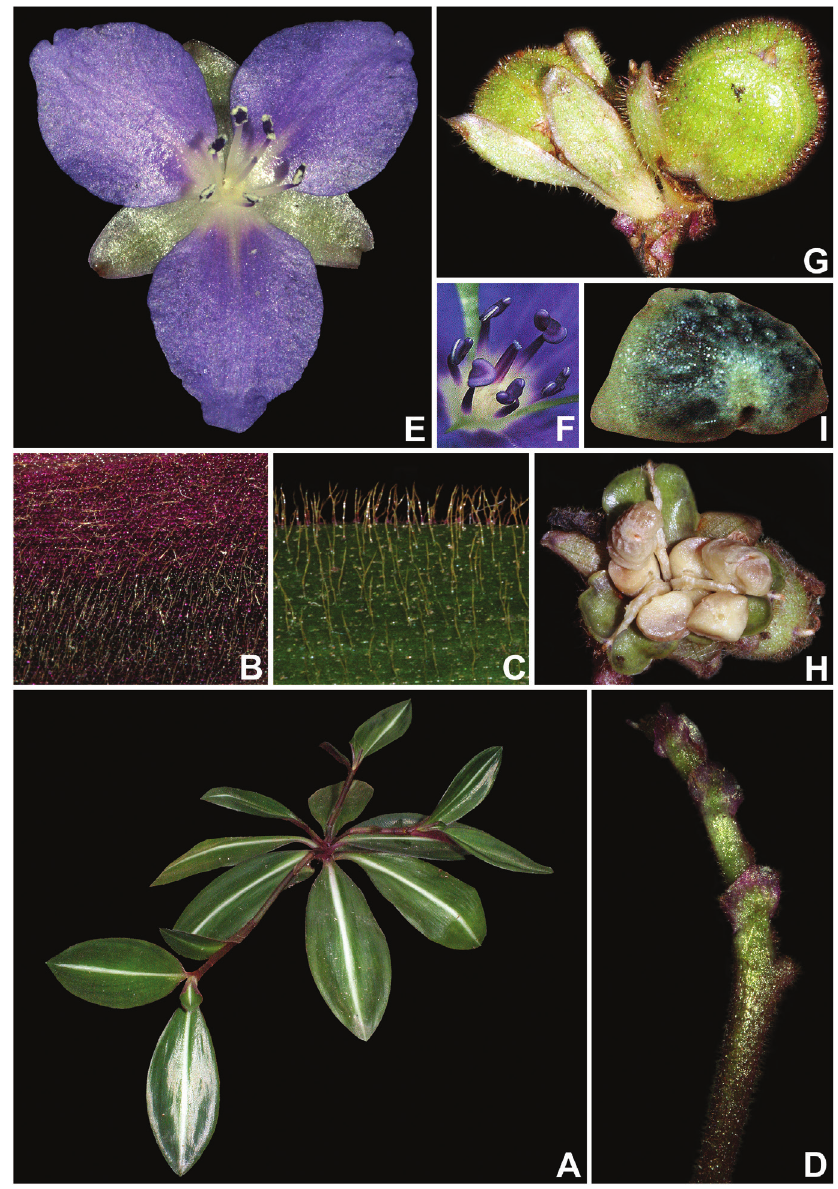
Figure 6. Siderasis albofasciata M.Pell. A habit, showing the well-defined white stripe along the midvein of the leaves and the flagelliform-shoots with terminal rosettes B detail of the abaxial side of the leaf, show- ing the light-brown lanate indumentum C detail of the adaxial side of the leaf, showing the light-brown hispid indumentum D detail of the inflorescence, showing the solitary cincinnus E flower F detail of the androecium and the gynoecium G detail of the capsules, the left one immature with evident accrescent sepals and the right one mature H detail of an open capsule, showing the biseriate to partially uniseriate, arillate seeds I dorsal view of a seed, showing the semi-lateral embryotega and the cream-colored, slightly translucent and thick aril. Photograph F by L. Kollmann, remaining by M.O.O.